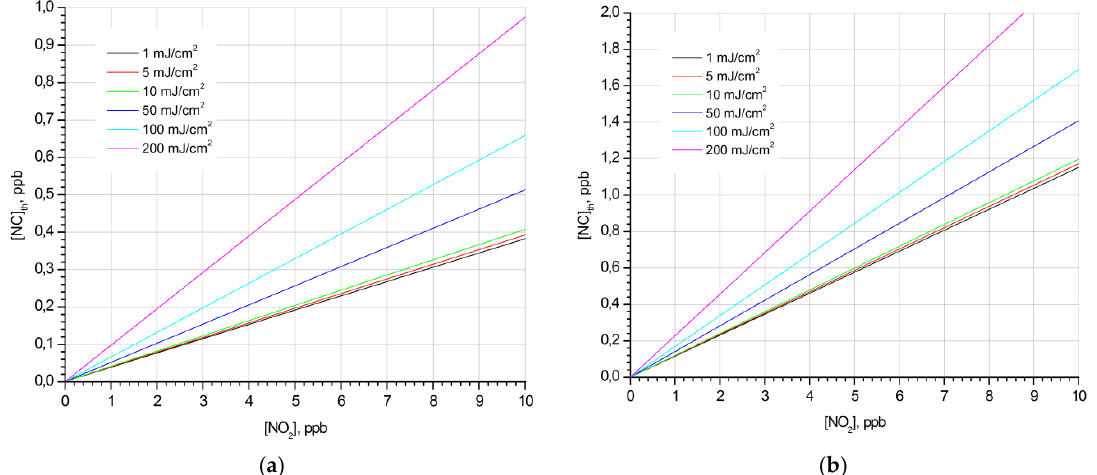
Figure 2. Dependence of the maximum detectable concentrations of nitrobenzene ( a ) and o -nitrotoluene ( b ) vapors [Nc] th on the concentration of atmospheric nitrogen dioxide [NO 2 ] at given values of the radiation energy density.